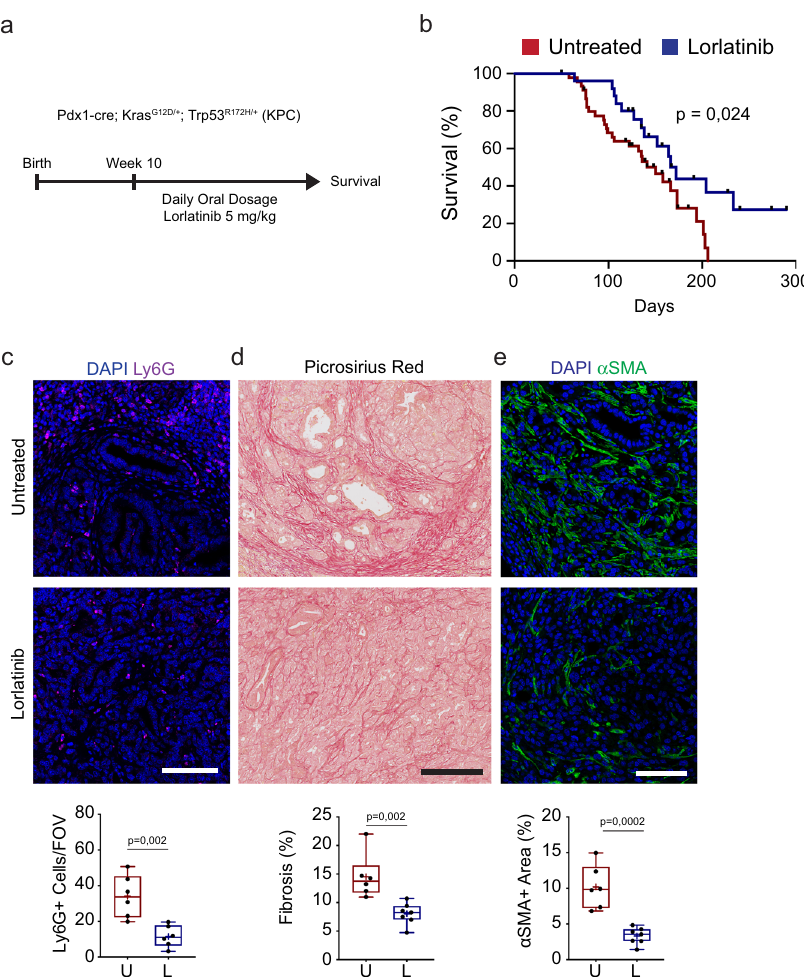
Fig. 4 Lorlatinib treatment extends the survival of KPC mice. a KPC mice with spontaneous development of PDAC were treated daily with 5 mg/kg lorlatinib starting when mice reached 10 weeks of age until they developed signs of disease progression. b Kaplan – Meier survival plot of KPC mice treated from 10 weeks of age with lorlatinib ( n = 25 mice) or untreated ( n = 46 mice). Mice euthanized due to other pathologies are censored and cross-marked; P value by log-rank test. c Representative immuno fl uorescence images and quanti fi cation of neutrophils (Ly6G + ; purple) in PDAC tumors collected from untreated or lorlatinib-treated KPC mice at the end of the experiment ( n = 6 mice, untreated; n = 6 mice, lorlatinib; data are from one experiment). Five FOV were acquired per mouse and used for quanti fi cation of Ly6G + cells. d Representative picrosirius red staining and quanti fi cation of fi brosis in PDAC tumors collected from untreated or lorlatinib-treated KPC mice at the end of the experiment ( n = 6 mice, untreated; n = 7 mice, lorlatinib; data are from one experiment). e Representative immuno fl uorescence images and quanti fi cation of fi broblasts ( α SMA + ; green) in PDAC tumors collected from untreated or lorlatinib-treated KPC mice at the end of the experiment ( n = 6 mice, untreated; n = 7 mice, lorlatinib; data are from one experiment). Scale bars represent 250 µ m ( d ) or 100 µ m ( c , e ). Box-and-whisker plot shows the median (line), mean (plus sign), 25th and 75th percentiles (box), and 5th and 95th percentiles (whiskers); hypothesis testing performed using unpaired two-sided Student ’ s t test. Source data are provided as a Source Data fi